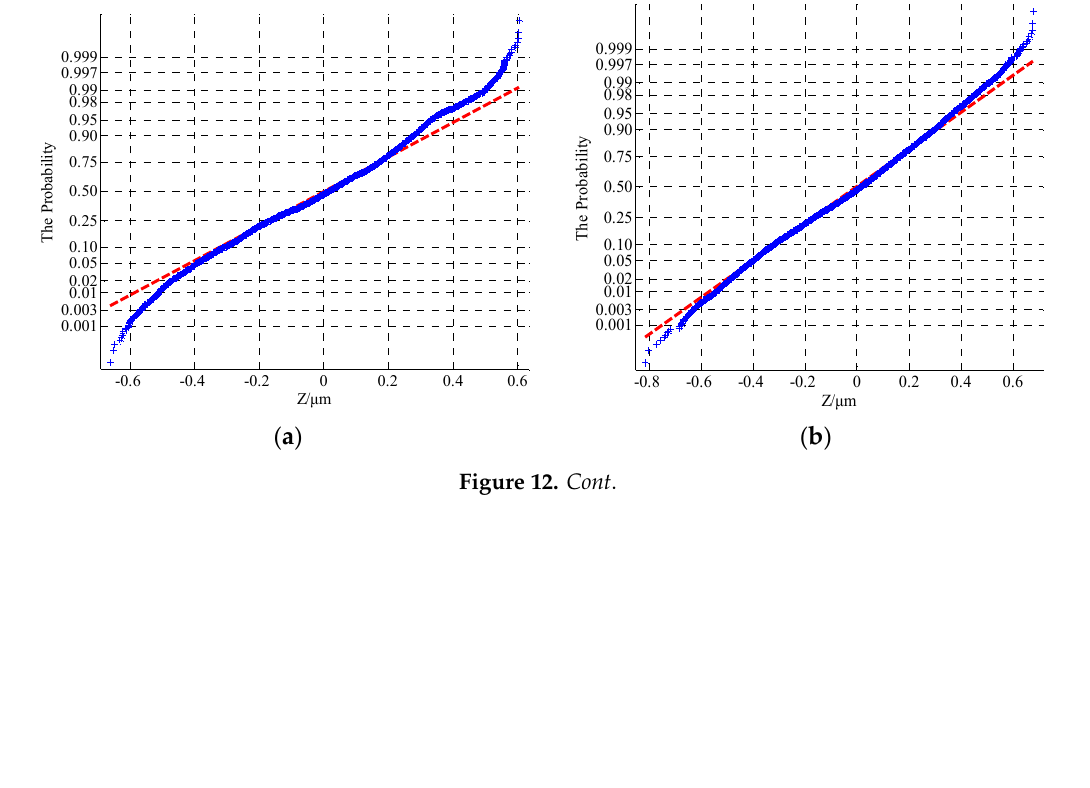
Figure 12. The probability density for different D and G : ( a ) D = 1.5, G = 0.12; (b) D = 1.7, G = 0.12; ( c ) D = 1.5, G = 0.52.